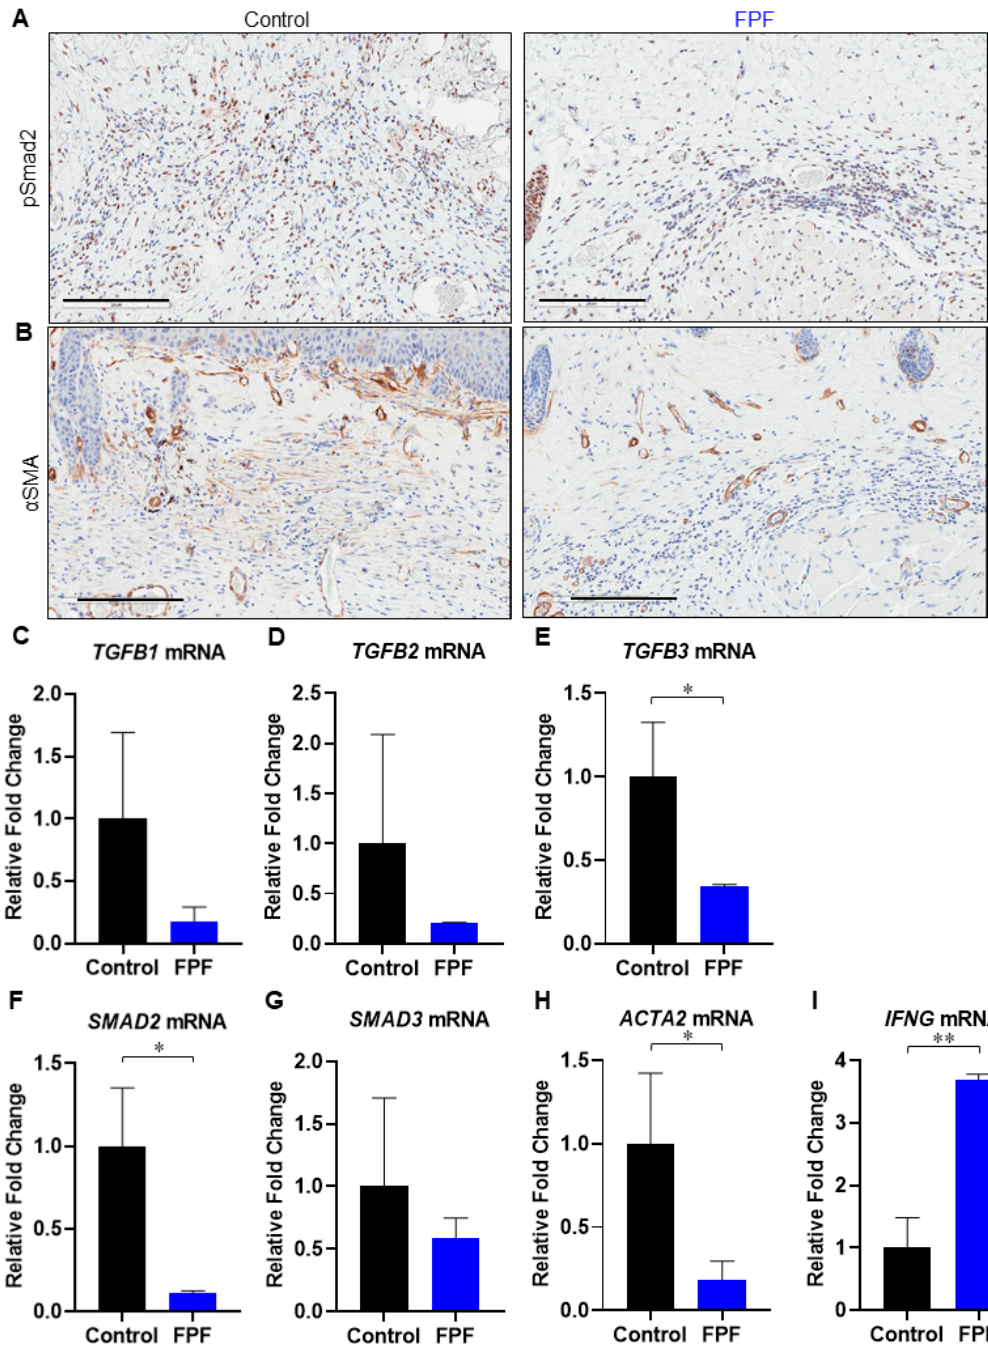
Figure 4. Activation of TGF- β signaling is hindered in FPF-treated mice. Immunohistochemical analysis of paraffin tissue sections from control ( left panel ) and FPF-treated ( right panel ) mice. ( A ) pSmad2 staining revealed fewer pSmad2-positive cells in FPF-treated mice ( right panel ) than in control mice ( left panel ), demonstrating that TGF- β signaling was disrupted following FPF treatment. ( B ) Staining for α SMA showed fewer α SMA-positive cells in FPF-treated mice ( right panel ) than in control mice (left panel), suggesting that myofibroblast differentiation was reduced following FPF treatment. Representative images of five animals per group are shown. Scale bars= 200 µm. RT 2 qPCR for ( C ) TGFB1 , ( D ) TGFB2 , ( E ) TGFB3, ( F ) SMAD2 , ( G ) SMAD3 , ( H ) ACTA2 , ( I ) IFNG in control (black bars) and FPF (blue bars)-treated mice. N = 3 mice/group. * p < 0.05, ** p < 0.01.